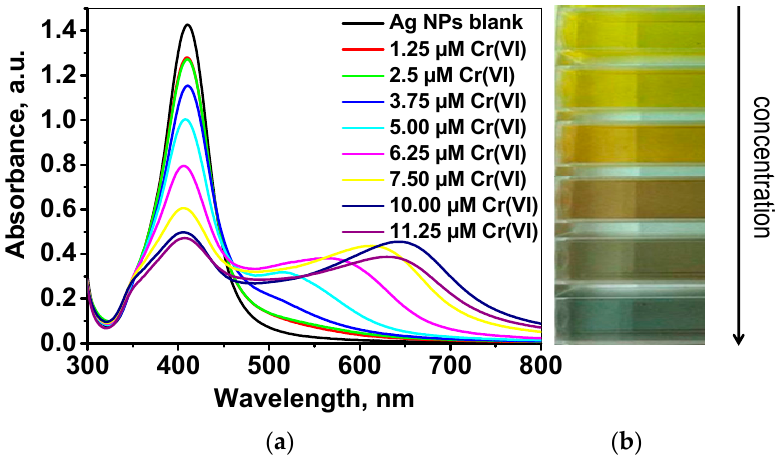
Figure 4. ( a ) UV-Vis absorption spectra and ( b ) color changes of Ag/Raff NPs recorded 5 min after addition of Cr(VI) standard solutions with increasing concentrations, in situ reduced with ascorbic acid at pH 4.